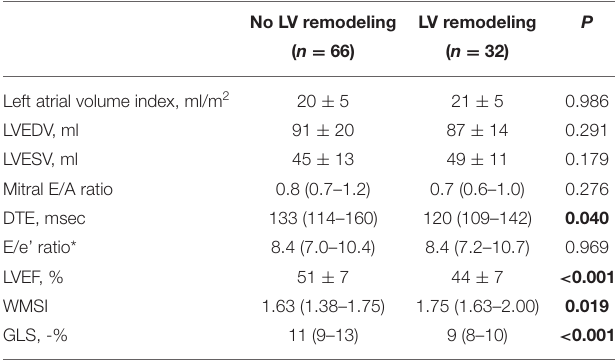
TABLE 2 | Baseline echocardiographic characteristics of patients with or without LV remodeling. No LV remodeling LV